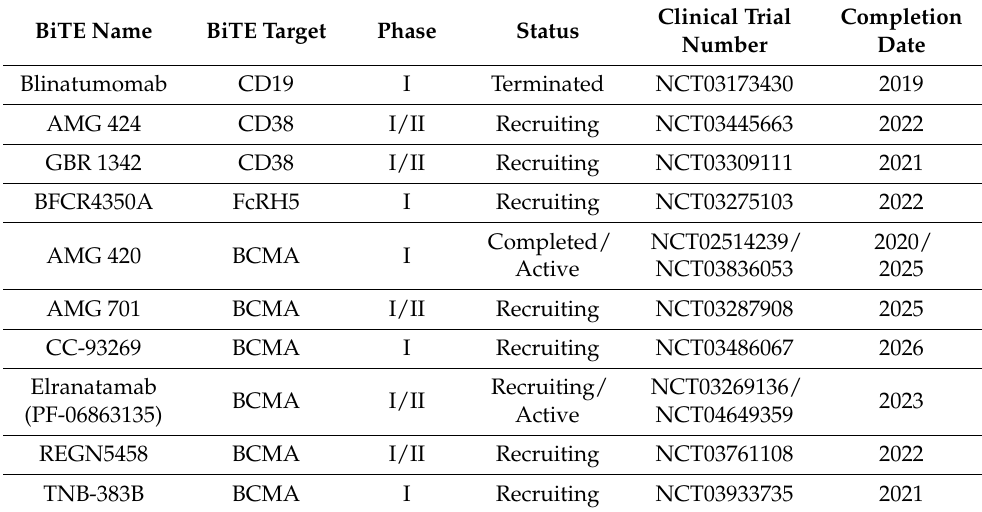
Table 1. BTCE Clinical Trials in Multiple